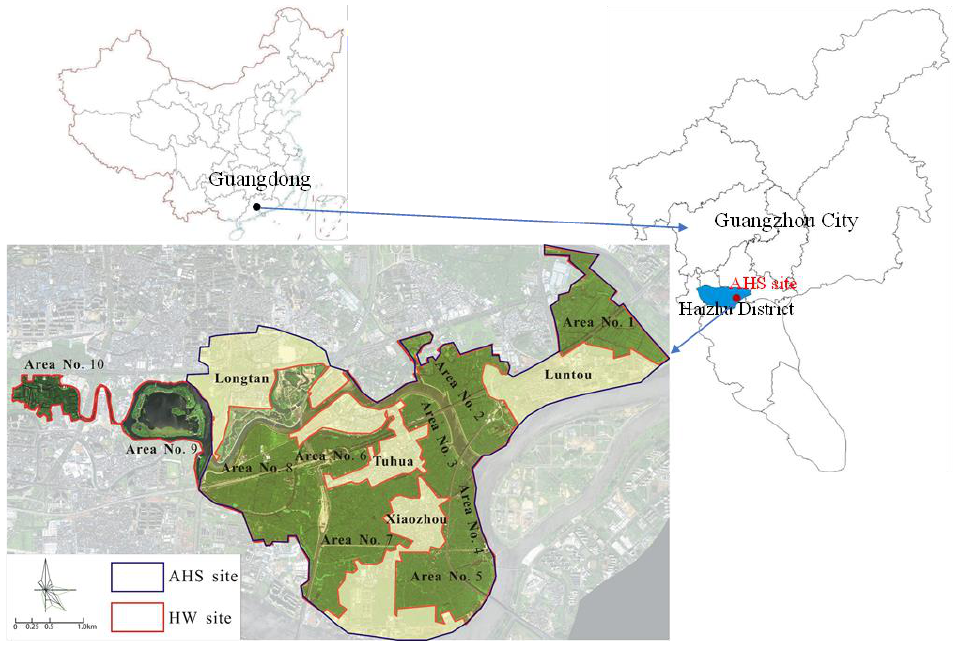
Figure 1. Location of the study area.